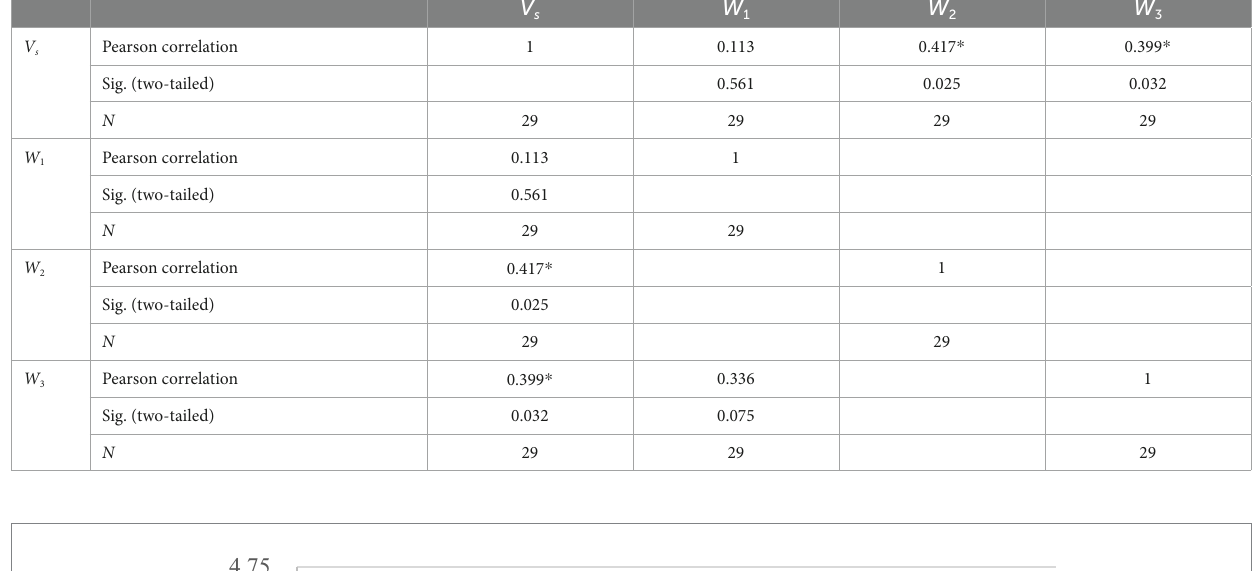
TABLE 6 Correlation between the subjects’ speech rate and the expected feedback speech rate.